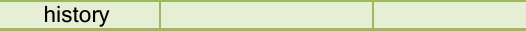
Table 2: The response to risedronate as assessed by BMD measurement and fracture number.